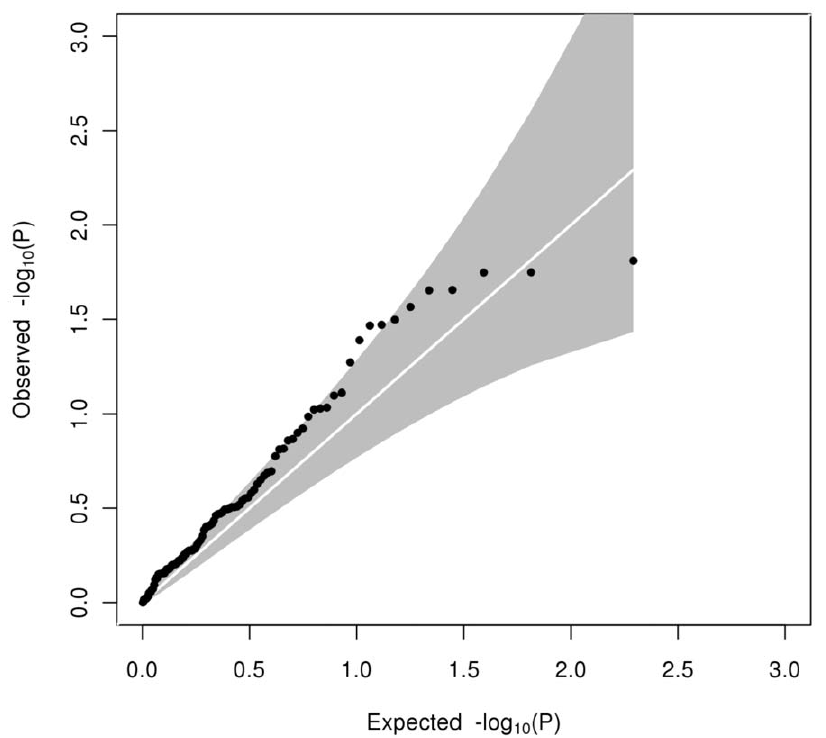
Figure 1. Quantile-quantile plot of observed against expected heterogeneity P-value for allelic associations with HDL-C. The grey shaded area represents the 95% confidence interval.